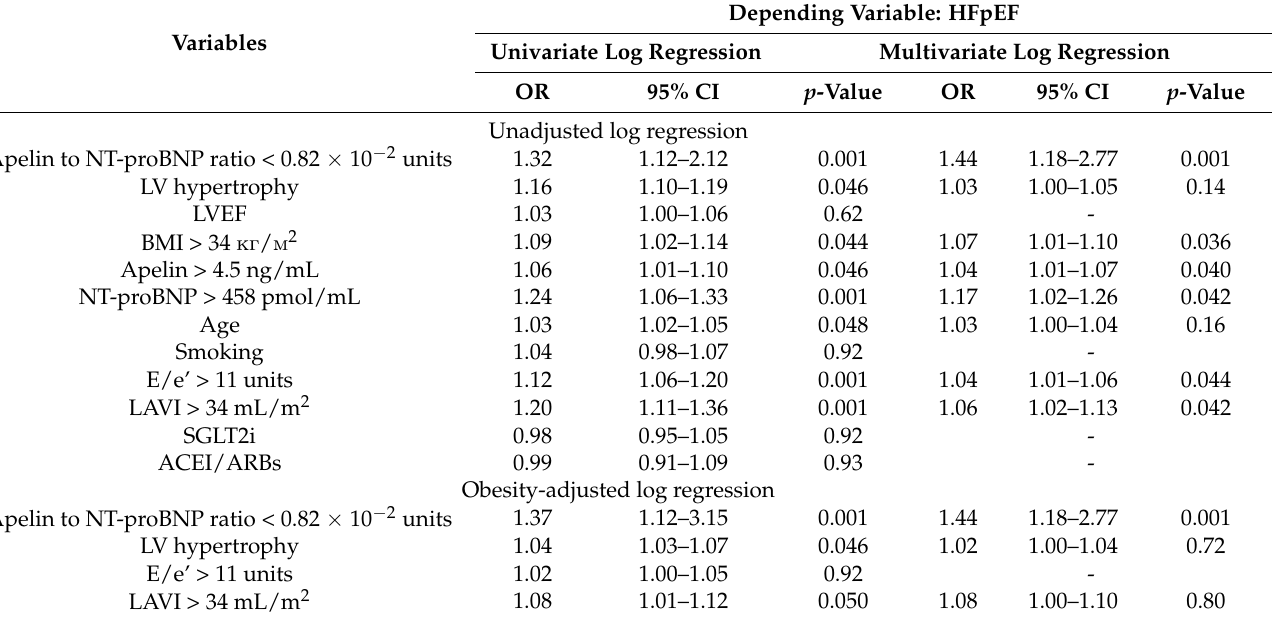
Table 3. Predictors for depending variable (HFpEF) in T2DM populations. The results of the univariate and multivariate log regression